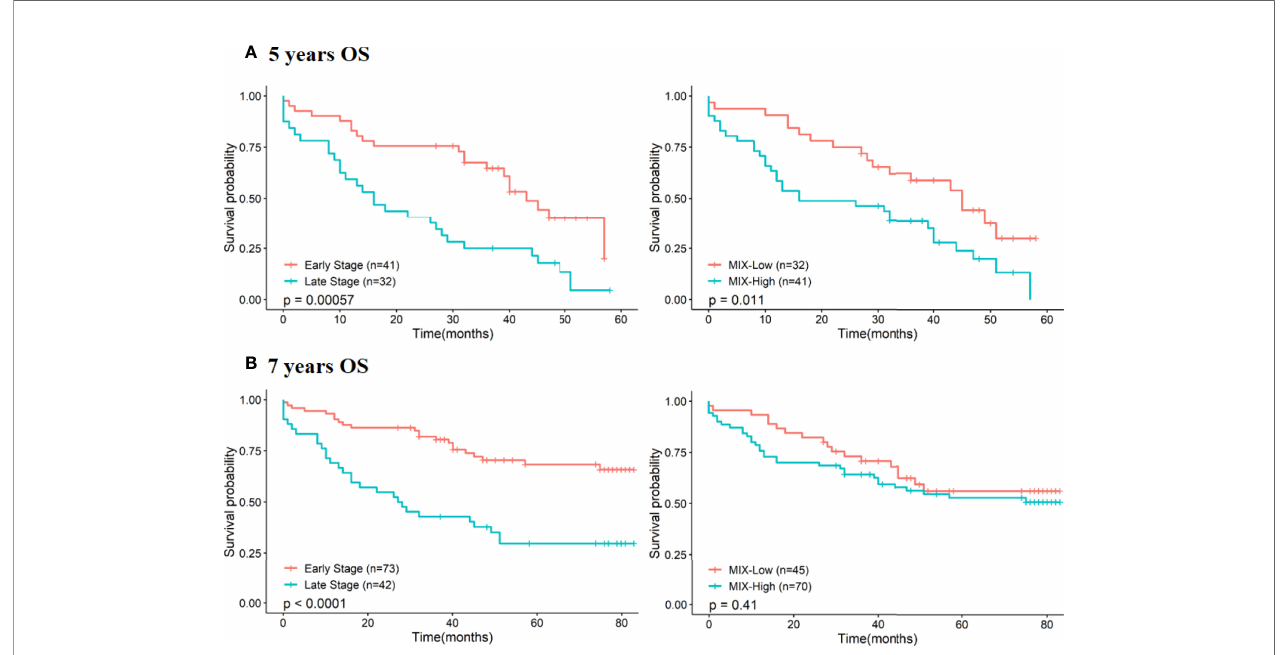
FIGURE 3 | Association between pTNM staging and MIX scoring with survival rates at 5- and 7 years (60 and 84 months respectively). Prognostic value of each feature (pTNM staging and MIX staining) was assessed using the Kaplan-Meier method and log-rank test by strati fi cation of patients according to early and late stages or MIX-Low and High scoring at 5-years of OS (A) and at 7-years of OS (B) . OS, Overall Survival; pTNM, pathology Tumor Node Metastasis. TABLE 3 | Prognostic values of clinicopathological features (gender, age, stage and MIX staining) at 5- and 7 years of patients ’ follow-ups (60 and 84 months respectively). (A) Univariate Cox analysis Multivariate Cox